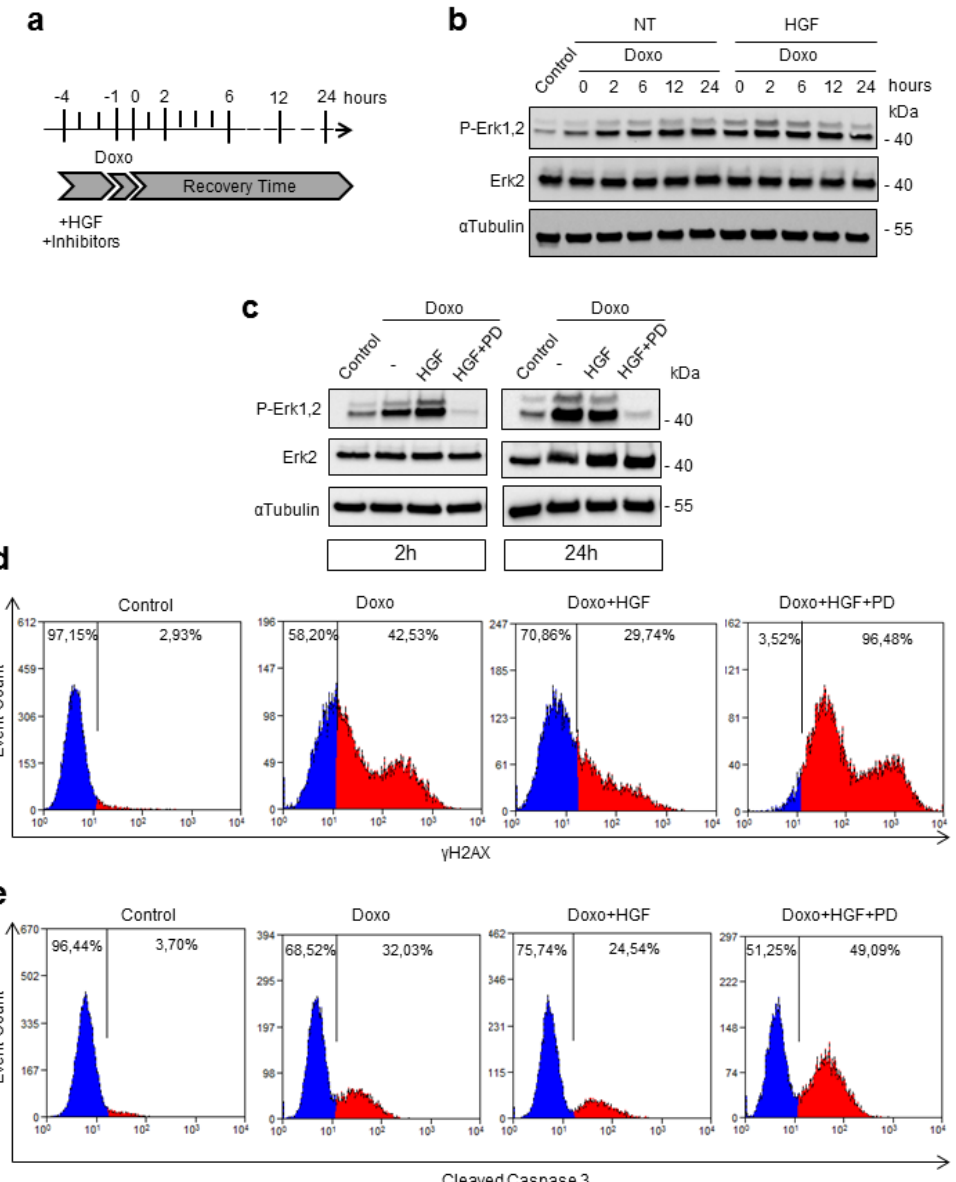
Figure 1. Hepatocyte growth factor (HGF) protects cardiomyoblasts against doxorubicin (Doxo)-induced DNA damage and apoptosis and the inhibition of Erk1,2 (extracellular signal-regulated kinase 1,2) dampens this cardioprotection. ( a ) Scheme of the experimental protocol used for treatments. H9c2 cardiomyoblasts were incubated with Doxo (25 μM) for 1 h (Doxo pulse) or pretreated for 4 h with HGF (0.5 nM) alone or HGF+PD (PD98059, Erk inhibitor) and exposed to Doxo in the last hour. Then, the cells were replaced with fresh low serum medium (recovery time). ( b ) Control, Doxo- and Doxo+HGF-treated cells were analyzed at different time points of the recovery time (0, 2, 6 12 and 24 h). ( c ) Control, Doxo-, Doxo+HGF- and Doxo+HGF+PD-treated cells were analyzed at 2 and 24h of recovery time. P-Erk1,2 and total Erk2 proteins were detected by Western blotting. αtubulin was used as the loading control in all Western blots. ( d ) The level of γH2AX protein was analyzed by flow cytometry. ( e ) The level of cleaved caspase 3 protein was analyzed by flow cytometry. Data are representative results of three independent experimental replicates.